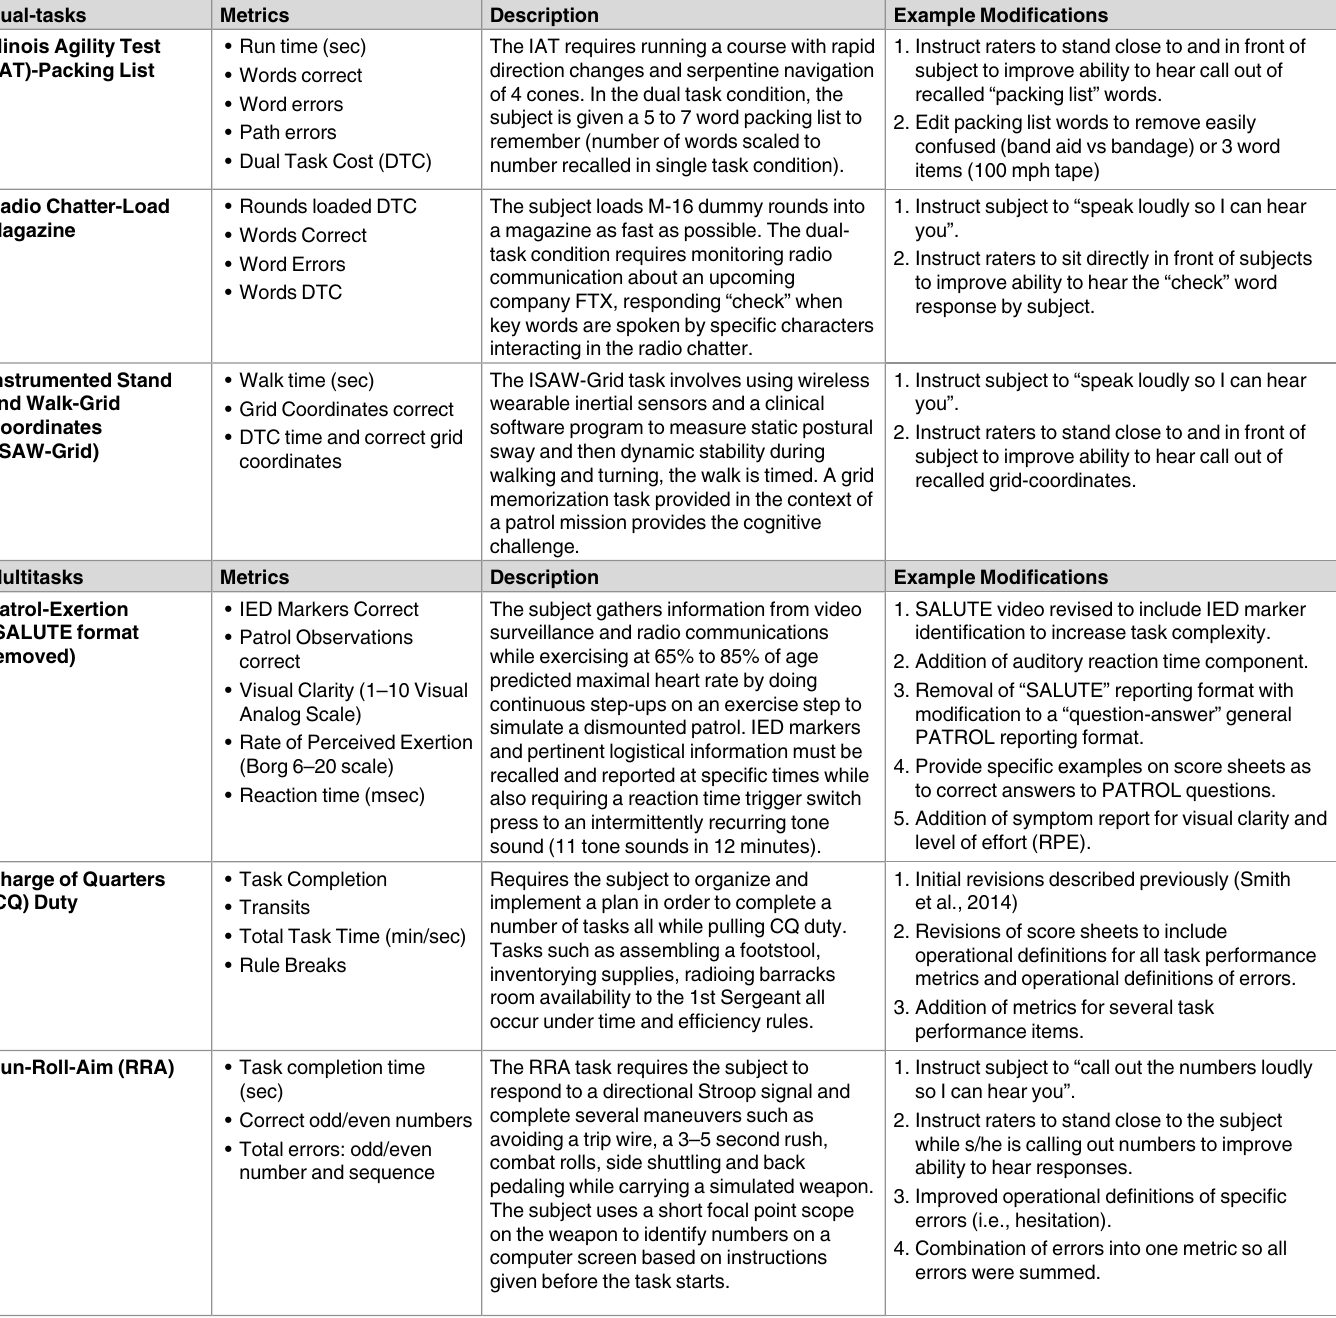
Table 1. The Assessment of Military Multitasking Performance tasks, metrics and example